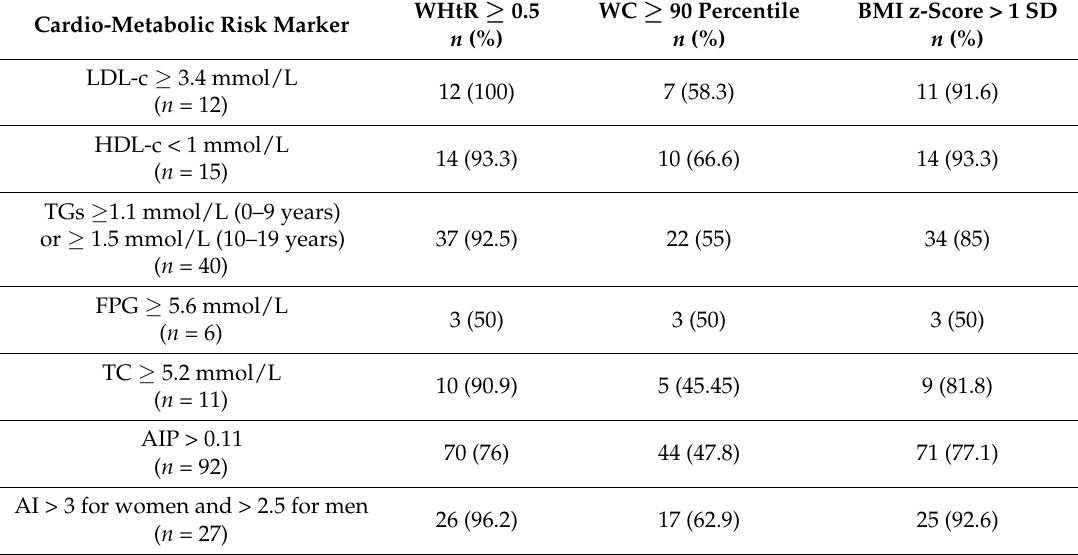
Table 2. Proportion of children with obesity by the three adiposity indicators among those with cardio-metabolic risk